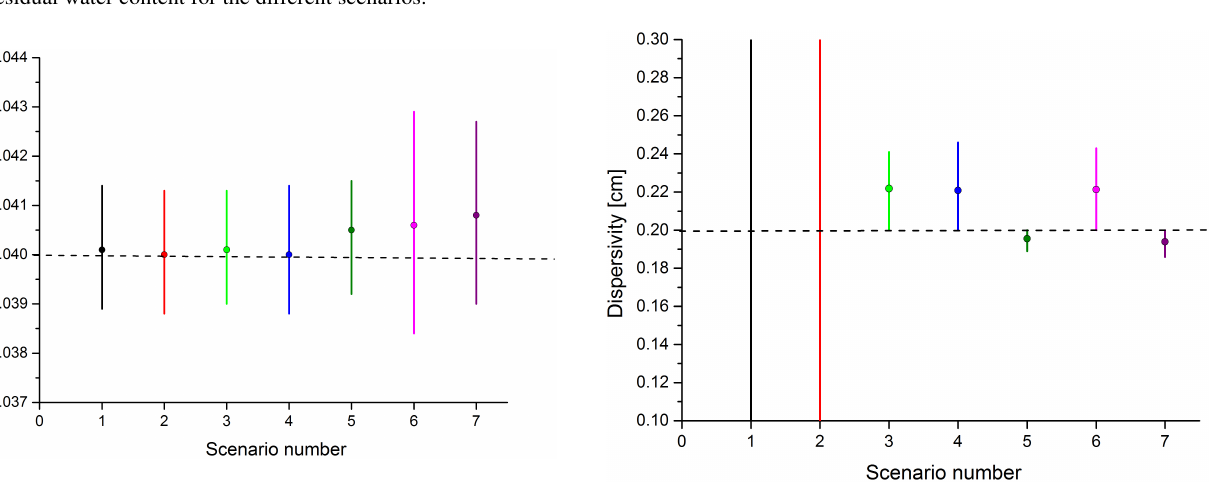
Figure 11. Posterior mean values and 95% confidence intervals of the residual water content for the different scenarios.